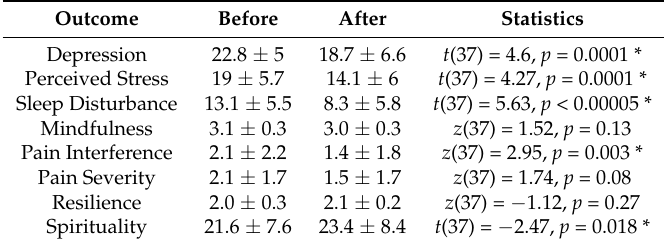
Table 3. Outcomes before and after IMMI for all participants ( n = 39).